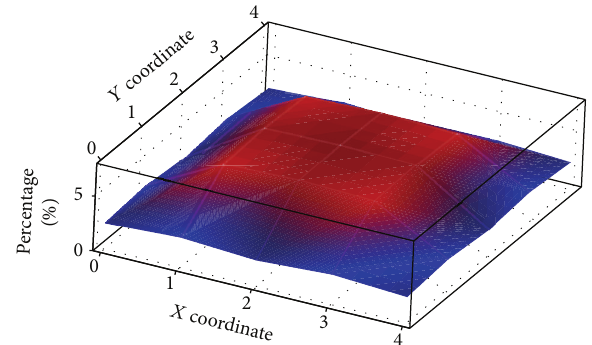
Figure 12: Distribution of the final “target” picture using the proposed method.